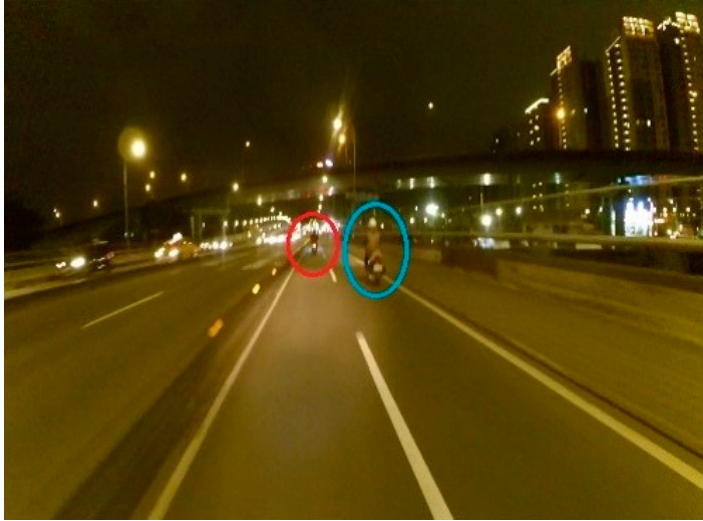
Figure 10. Example of objects occupying only a few pixels.